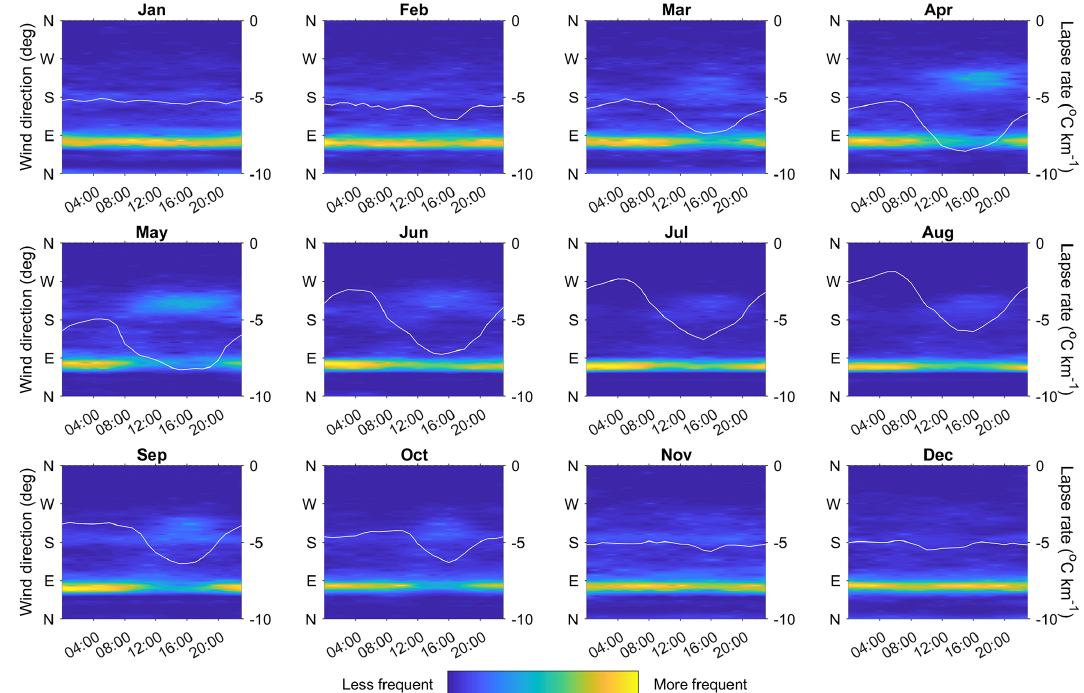
Figure B1. Monthly average hourly temperature lapse rates (white lines, right-hand axis) derived from AWS1 and AWS4 temperature time series overlying heat maps which represent the frequency distribution of hourly wind direction data from AWS4 (left-hand